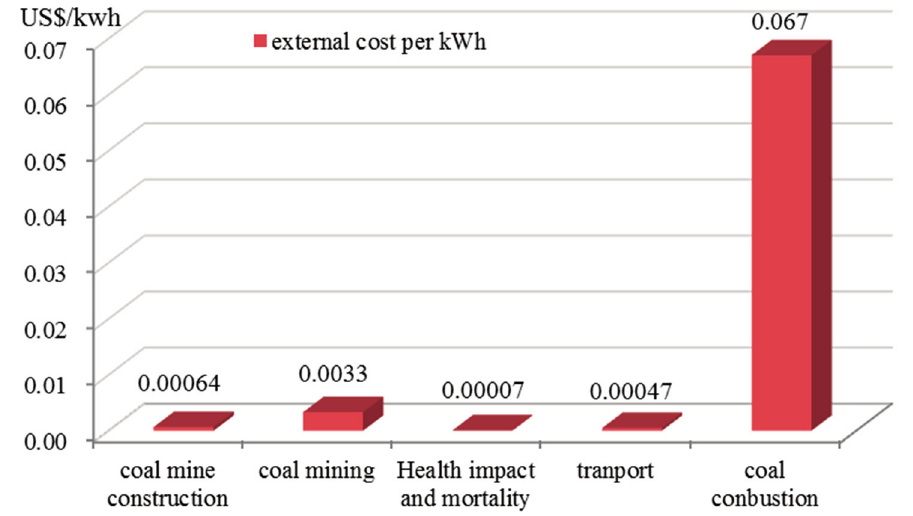
Figure 5. External costs of a 600 MW coal-fired power plant per kWh.